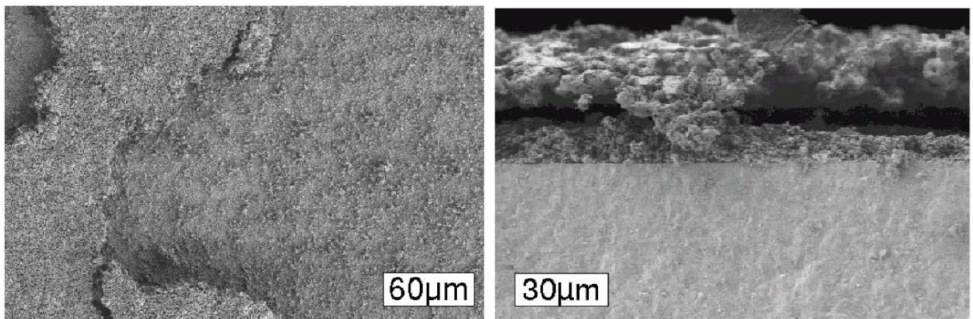
Figure 12. Delamination of anode and anode current collection layer in case of 8YSZ electrolyte supported cells after five RedOx cycles at 950 °C and 40 min. Right: Only Ni-8YSZ active anode; left: active anode plus Ni-8YSZ current collecting layer